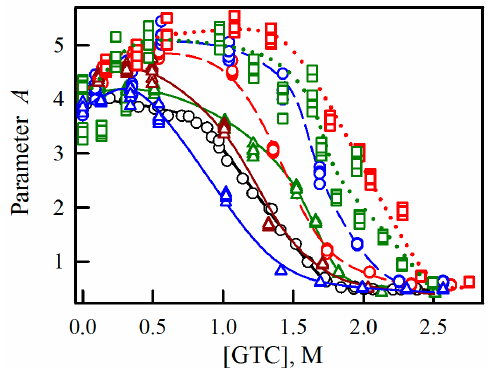
Figure 7. The effect of PEGs of different molecular weights on the denaturation of sfGFP induced by GTC. The change of parameter A ( A = I 320 / I 365 ) on GTC in the presence of PEG-600, PEG-8000, and PEG-12000 (designations are given in red, green and blue, respectively). The applied concentrations of PEGs were 8%, 20%, and 30% presented as triangles (and solid line), circles (and dashed line) and squares (and dotted line), respectively.